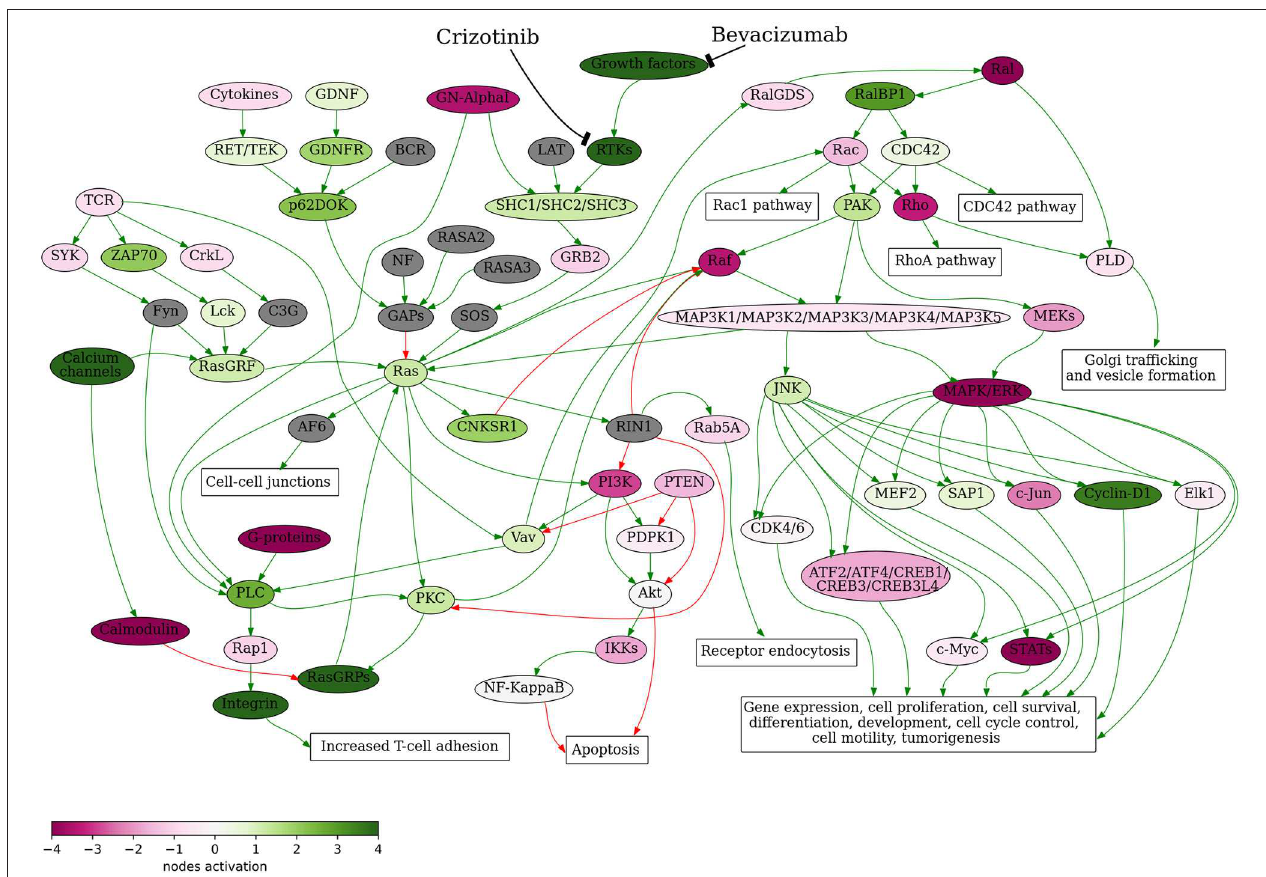
FIGURE 3 | Ras signaling pathway shown as an interacting network. This pathway was hyperactivated in the patient’s tumor tissue. Green arrows indicate activation, red arrows–inhibition. Transcript nodes are shown in ovals, interface molecular pathways and cellular effects–in rectangles. The color depth of transcript nodes reflects the extent of node activation (logarithms of the case-to-normal (CNR) expression rate for each node, in which “normal” is a geometric average between expression levels in normal tissue samples). Molecular targets of crizotinib and bevacizumab are indicated by black arrows. Visualization was implemented using Oncobox